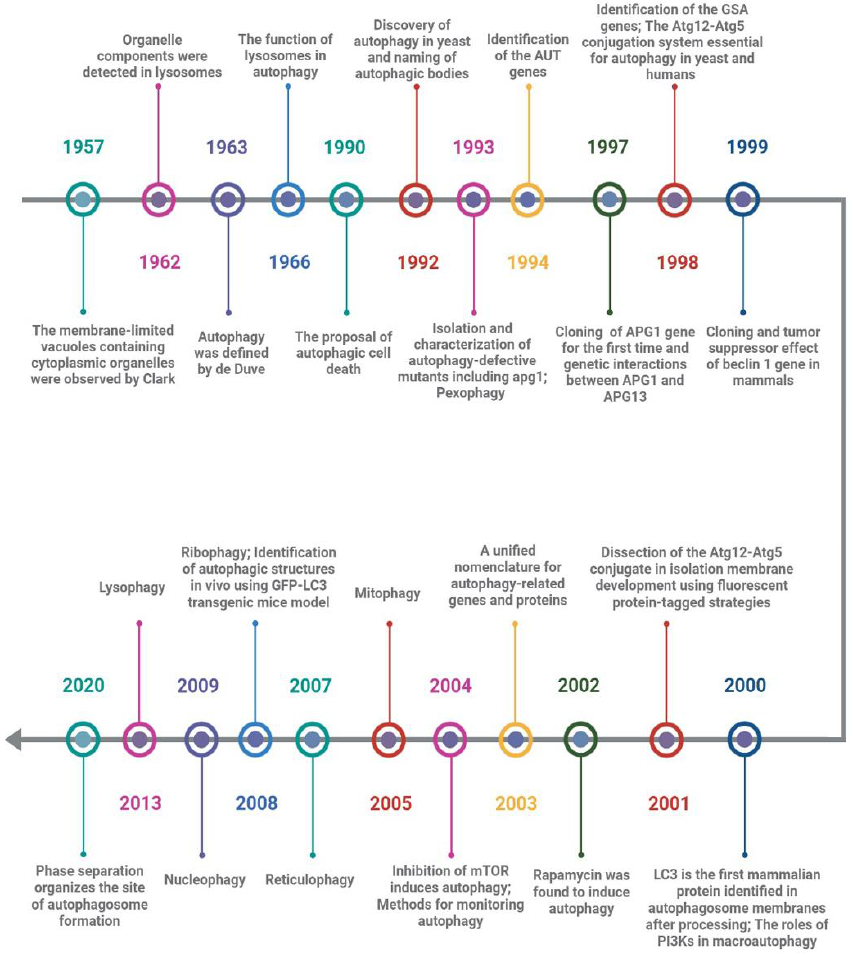
Figure 1. Timeline of historical events in autophagy. This timeline depicts the key discoveries of autophagy. Unfortunately, it is not possible to include all discoveries due to limited space.